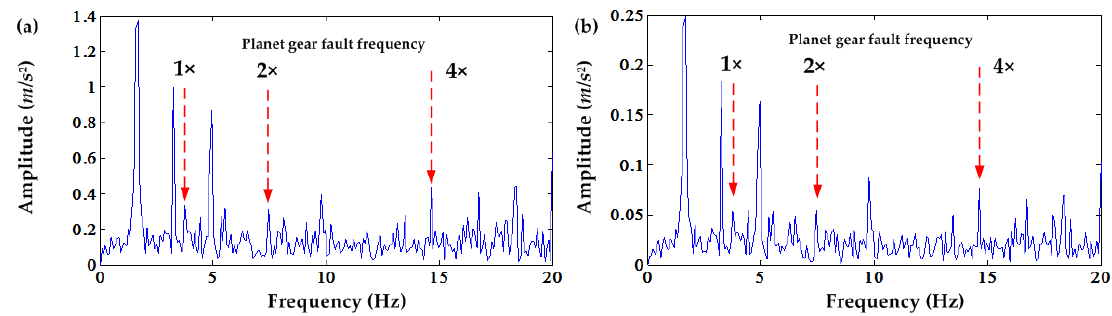
Figure 26. ( a ) Squared envelope spectrum after the first DC offset cancellation; ( b ) envelope spectrum of the original signal.